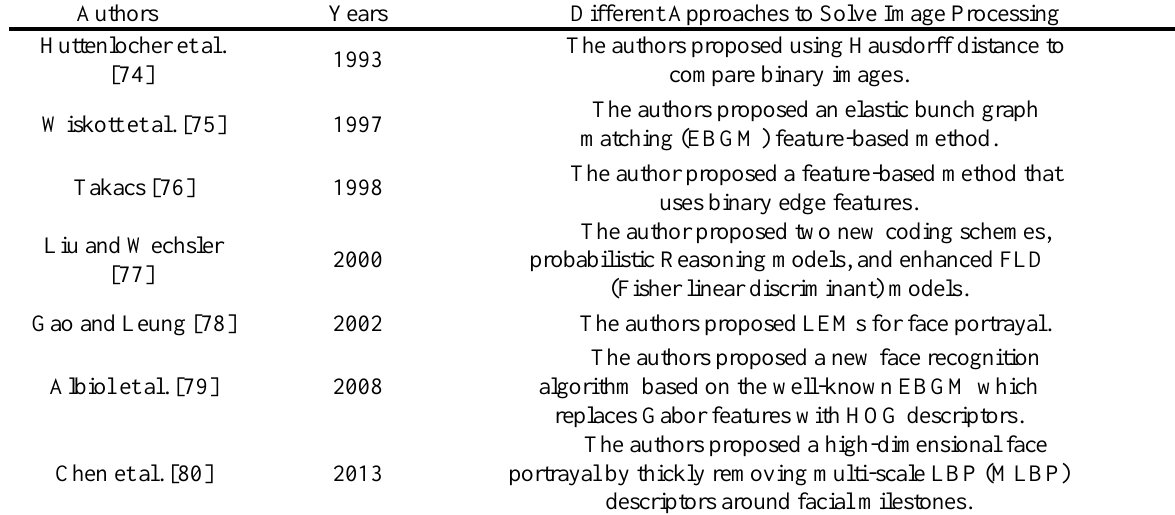
Table 2 discusses the contributions in Geometry and holistic based face detection. Table 2. A literature review of Geometry and holistic based face detection.